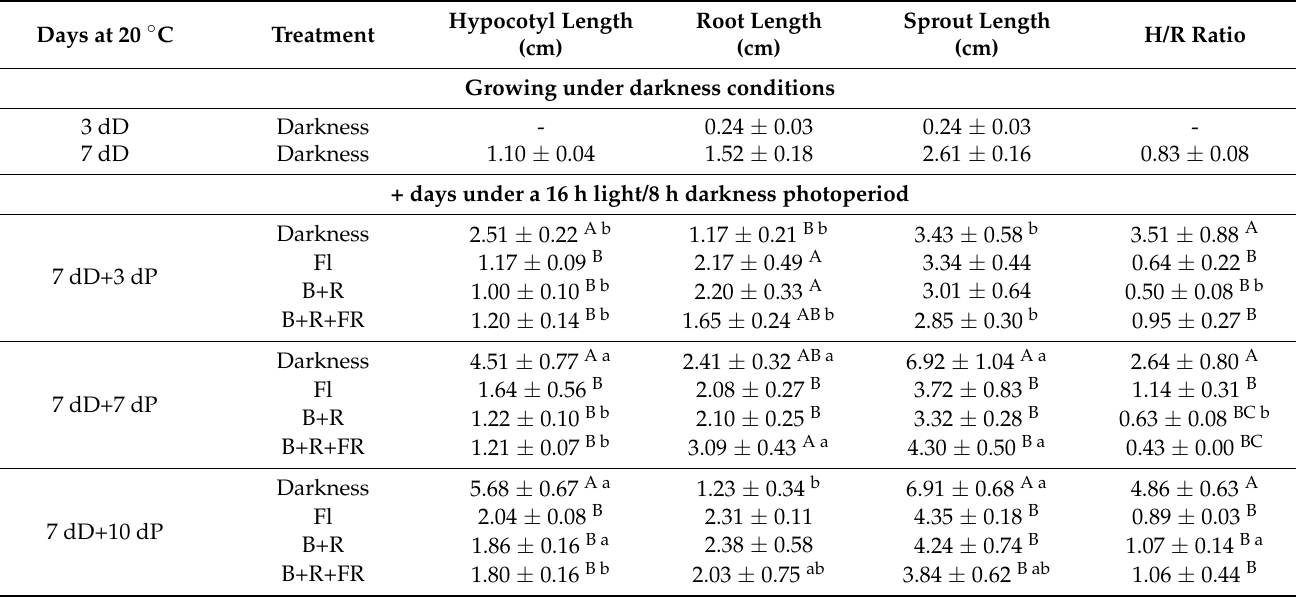
Table 1. Morphological development of carrot sprouts grown at 20 ◦ C during 7 days in darkness (dD)+10 days of a light/darkness photoperiod (dP) under several light treatments. Days at 20 ◦